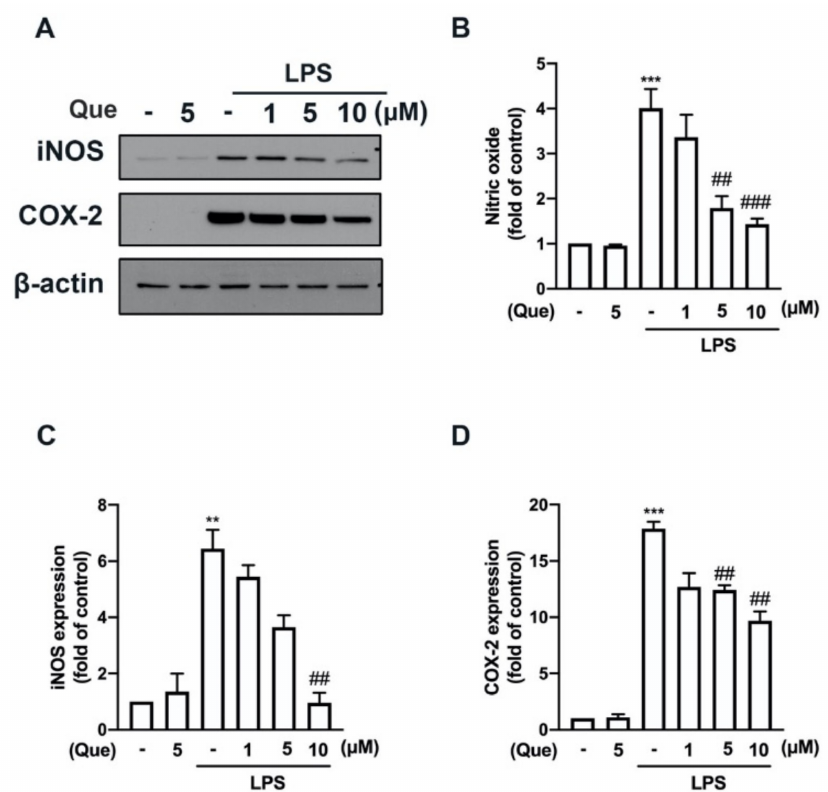
Figure 2. Inhibitory effects of quercetin on inducible nitric oxide synthase (iNOS) and cyclooxy- genase (COX)-2 expression levels in macrophages. RAW264.7 cells were stimulated with various concentrations of quercetin (1, 5, or 10 µ M) for 30 min followed by stimulation with LPS (50 ng/mL) for another 24 h. iNOS and COX-2 protein levels were determined by western blotting analysis ( A ). Quantitative results are shown in ( C , D ). ( B ) The supernatant was collected to determine nitric oxide (NO) production by the Griess reaction. Each bar represents the mean ± SEM of n = 3–4. Note: *** p < 0.005, ** p < 0.01 compared with the control group. ### p < 0.005, ## p < 0.01 compared with the LPS alone